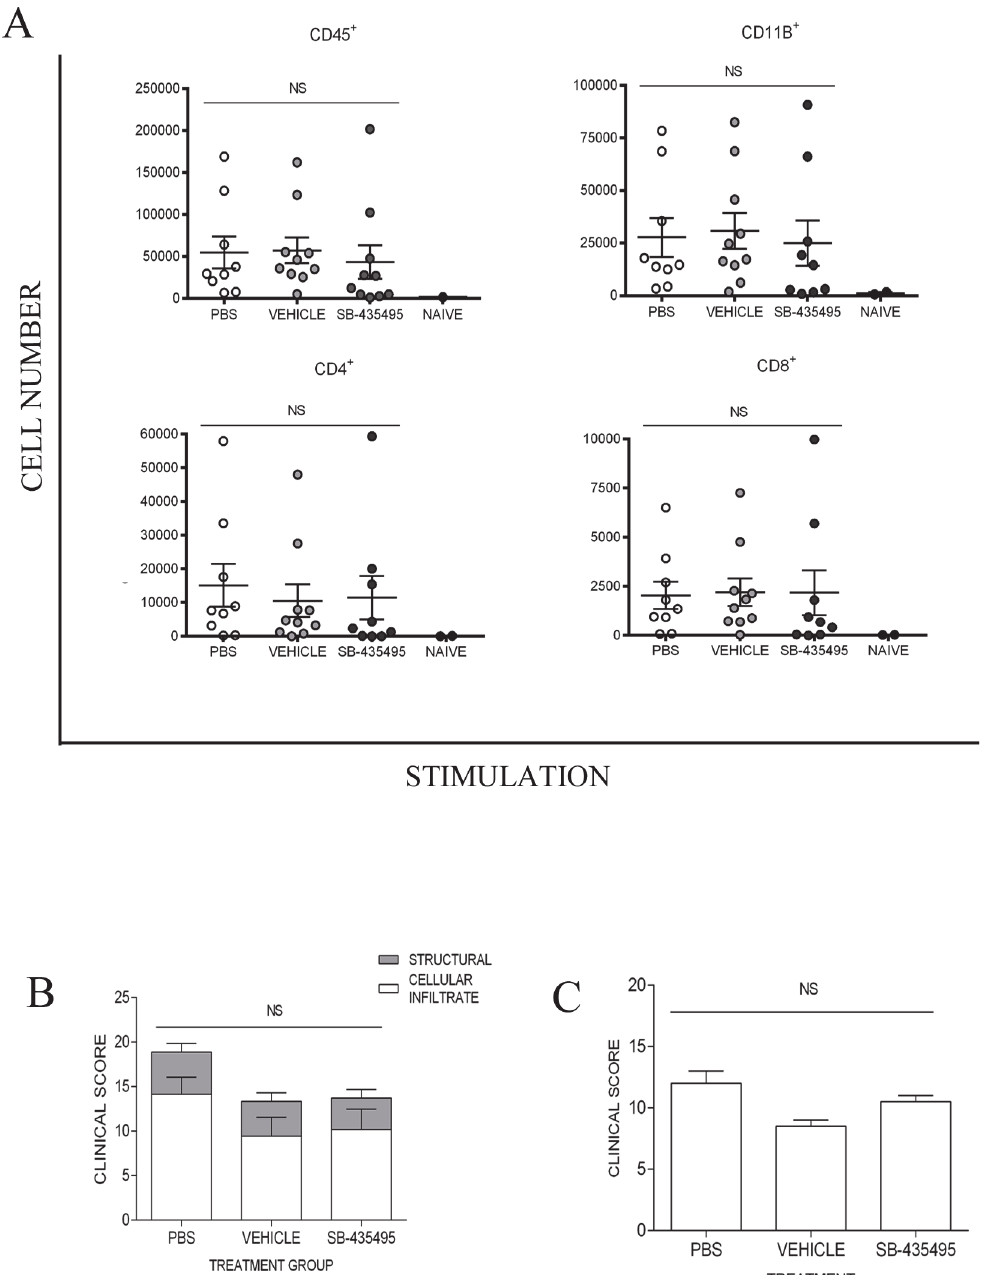
Fig 5. Quantification of retinal cellular infiltrate and onset of clinical disease in a murine model of EAU; effective of SB-435454. A) Flow cytometry data showing CD45 + , CD11b + , CD4 + and CD8 + cellular infiltrate in retinal digests from animals at day 14 post immunisation, treated twice daily with either SB-435495 or controls (n = 9 – 10 eyes). B) Histological staining scores from 12 μ m ocular sections taken from eyes enucleated at day 14 post immunisation, stained for CD45 + (DAB/haematoxylin) (n = 9 – 10 eyes). C) TEFI clinical score, day 13 post immunisation, (average scores provided by two independent assessors from two identical repeat experiments. n = 18 –